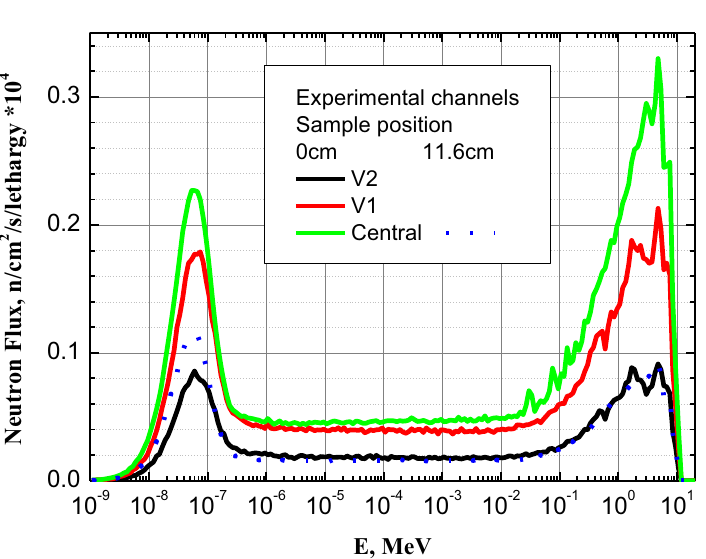
Figure 2. Neutron flux spectra in the experimental channels of neutron